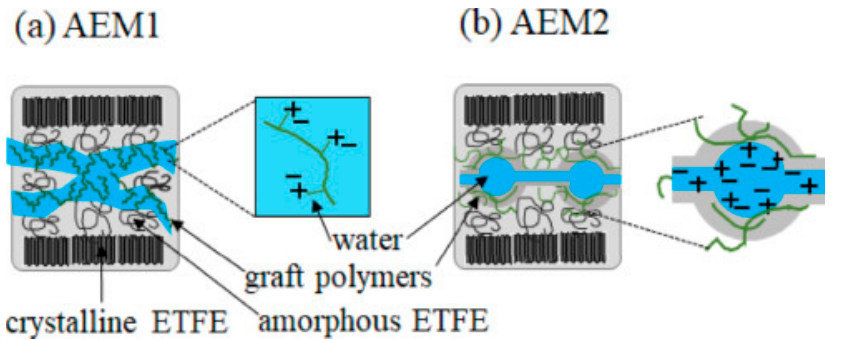
Figure 6. Schematic representation of ion channels of ( a ) parallel-grafted (AEM1) and ( b ) perpendicular-grafted (AEM2) ionic polymer into the ETFE polymer matrix. Reprinted with permission from [91] . Copyright Elsevier, 2018.